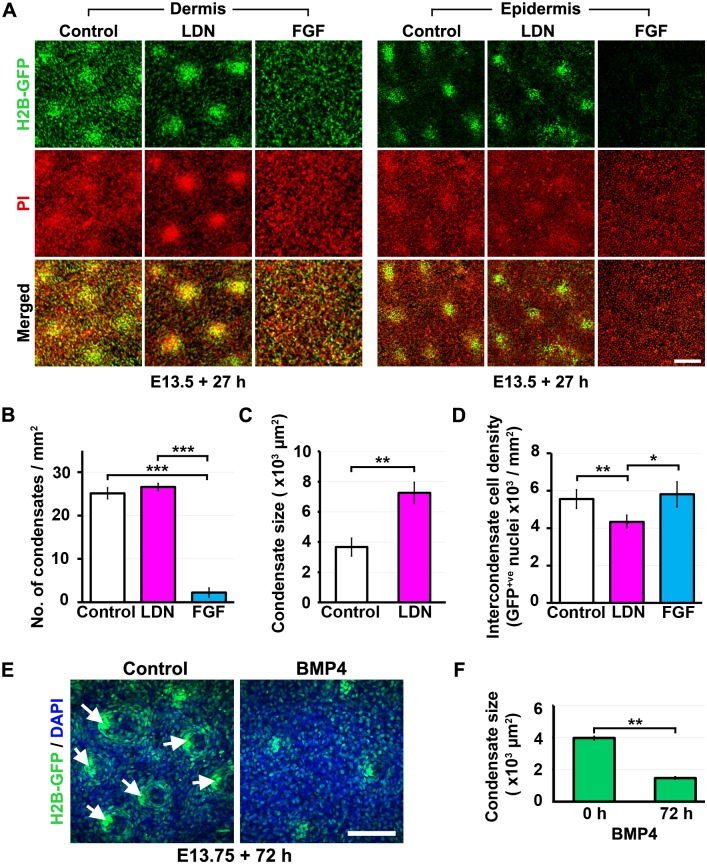
BMP destabilises mesenchymal aggregates.(A) Epidermis and dermis isolated from E13.5 TCF/Lef::H2B-green fluorescent protein (GFP) skin explants cultured with LDN193189 (LDN) (10 μM) or fibroblast growth factor (FGF) 9 (1 μg/ml) for 27 h, counterstained with propidium iodide (PI) and imaged using confocal microscopy. Scale bar: 100 μm. (B) Number of condensates per square mm, (C) mean condensate area, and (D) intercondensate cell density measured in E13.5 TCF/Lef::H2B-GFP skin explants cultured with either LDN or FGF. Error bars represent SEM from 5 independent experiments. Significant difference was calculated using a Student paired t test (*p < 0.05, **p < 0.01, ***p < 0.001). (E) E13.75 TCF/Lef::H2B-GFP skin explants (with pre-existing dermal condensates) were treated with bone morphogenetic protein (BMP) 4 for 72 h. Skins were counterstained with 4’6-Diamidino-2-phenylindole dihydrochloride (DAPI) and confocal imaged for GFP at 72 h. Scale bars: 100 μm. (F) Quantification of individual condensate area following BMP supplementation. Error bars represent SEM from at least 3 independent experiments. Significant difference was tested using a paired Student t test (*p < 0.05, **p < 0.01, ***p < 0.001). The raw numerical values (for B, C, D, and F) can be found in S3 Data.